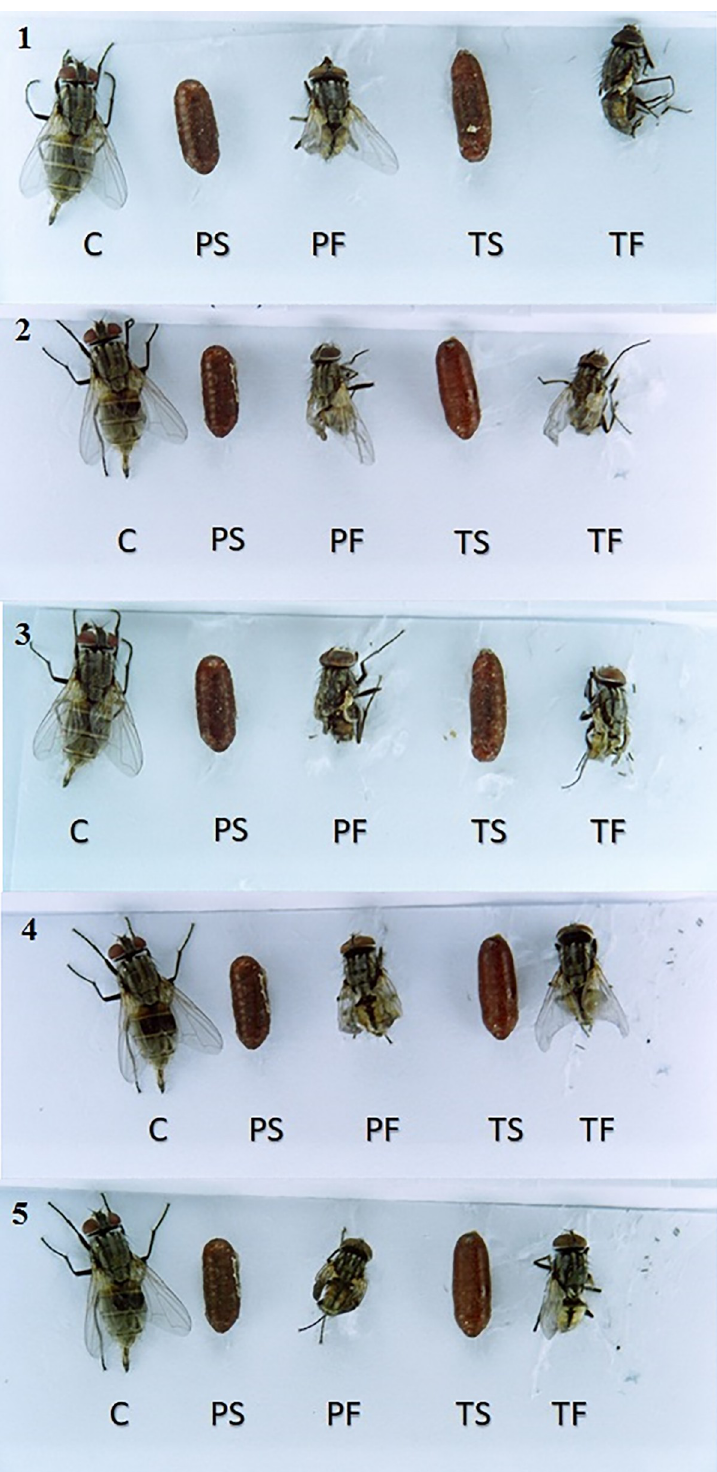
Fig 4. Adult deformity induced by pyriproxyfen and triflumuron on house fly strains. Adult insects deformation is observable after exposing 3 rd instar larvae to 0.625 ppm from each IGR. 1. Northside slaughterhouse strain, 2. Aziziya slaughterhouse strain, 3. As Saadah district slaughterhouse strain, 4. West Riyadh slaughterhouse strain and 5. Al- Munsiyah slaughterhouse strain. C: Control, PS: pyriproxyfen susceptible-strain, PF: Pyriproxyfen field-strain, TS: triflumuron susceptible-strain, TF: triflumuron field-strain.